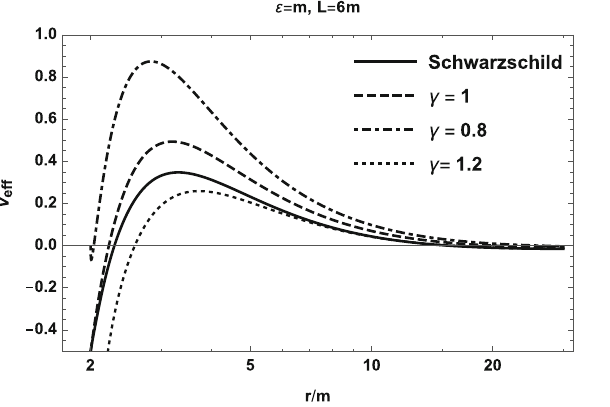
right panel V ef f ( r ) is plotted for γ = 0 . 8 and various values of p . As expected, notable departures from the Schwarzschild case appear for γ < 1 and p (cid:6)